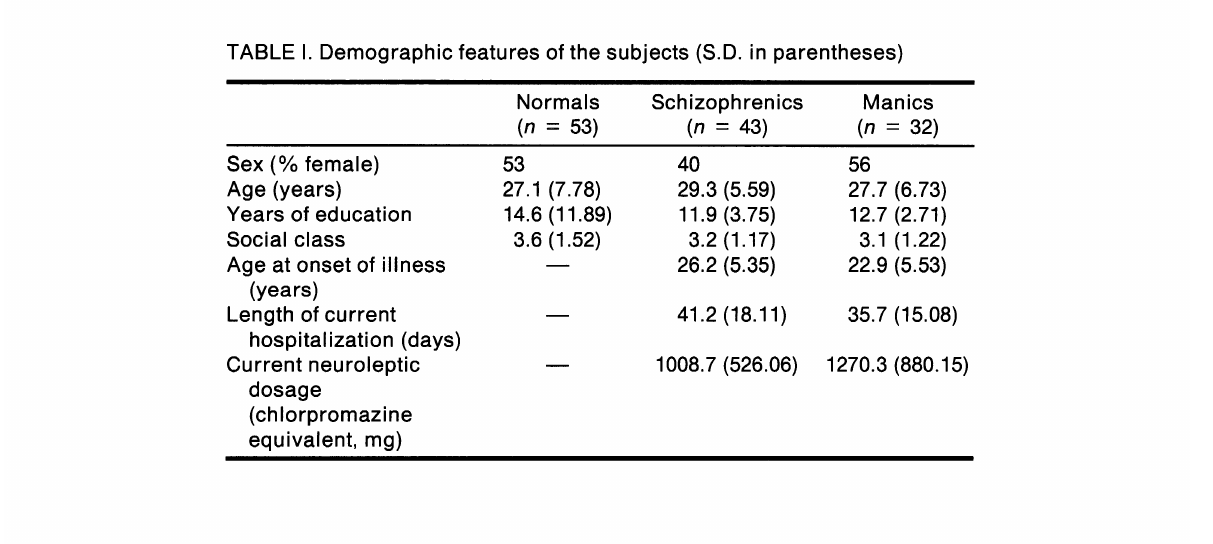
TABLE I. Demographic features of the subjects (S.D. in